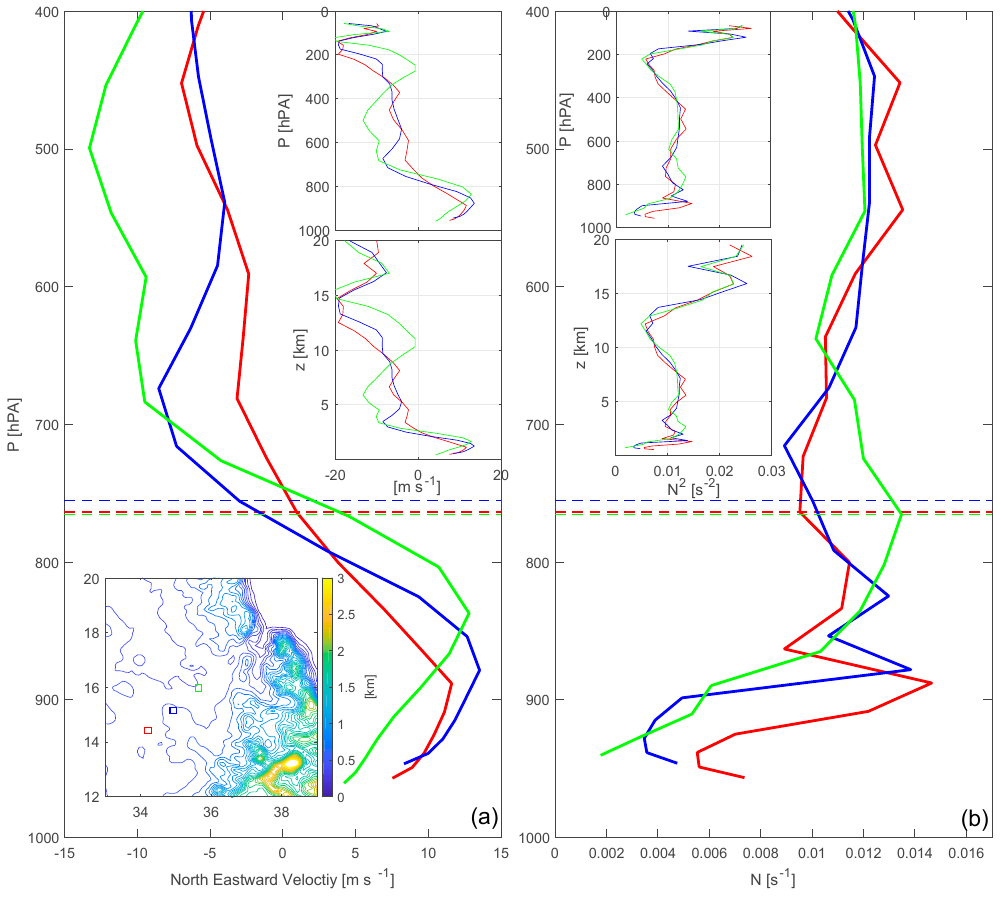
Figure 9. WRF profiles of the component of wind towards NE ( a ) and buoyancy frequency ( b ) taken at three stations upstream of the Tokar Gap at 7 / 12 / 2008 at 00 UTC. The station locations are indicated by the color boxes in the inset at the lower left of frame ( a ) showing topography contours. The z = 2500 m level, which roughly corresponds to the elevation of the highest peak in the Red Sea Hills, is indicated by a horizontal dashed line (one for each station.) The small inset profiles show the wind speed and N over the full elevation range of the model, both in z and in